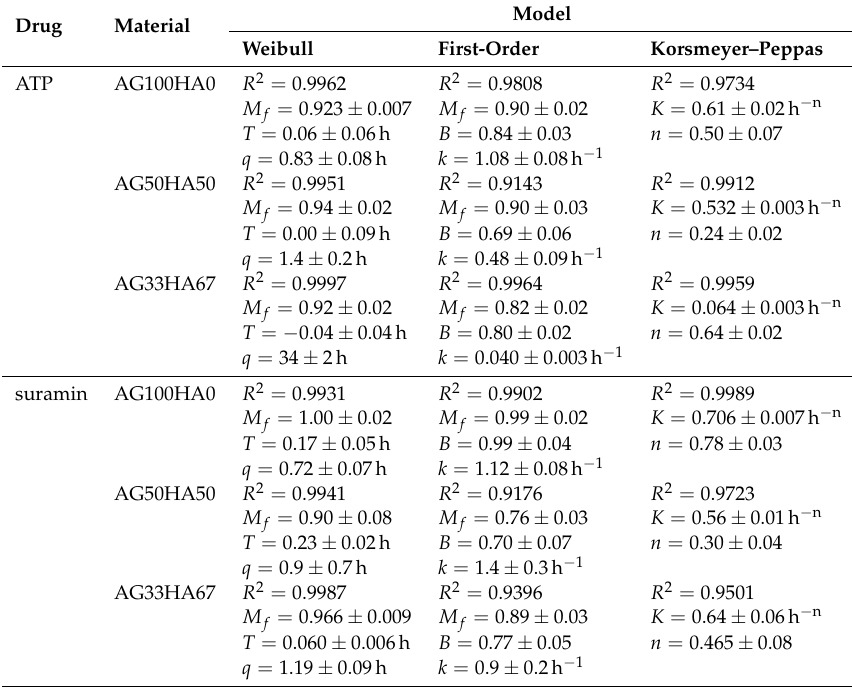
Table 2. Release profile fitting parameters for Weibull, first-order, and Korsmeyer–Peppas equations of ATP and suramin released from different scaffolds. n =